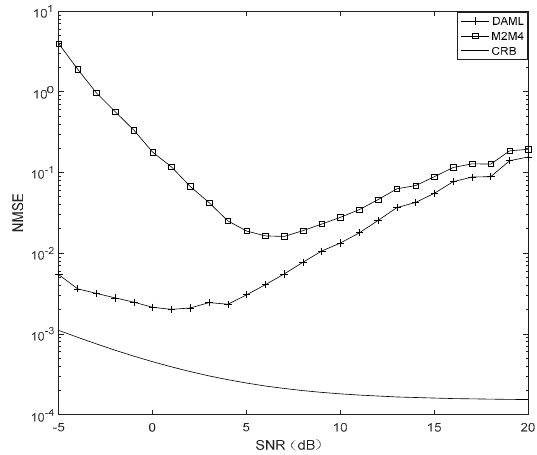
Figure 4. NMSE comparison of DA ML and M 2 M 4 in Ka-band fading channel.